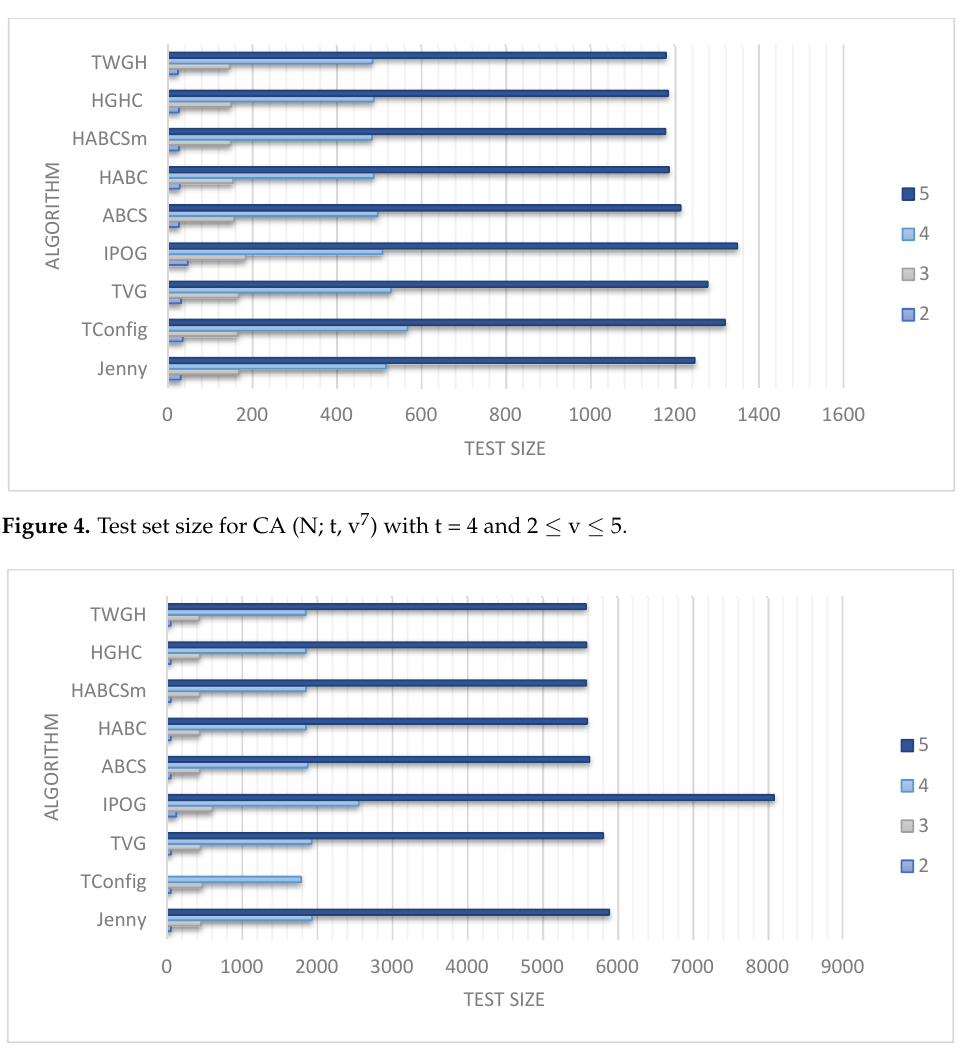
Figure 5. Test set size for CA (N; t, v 7 ) with t=5 and 2 ≤ v ≤ 5.